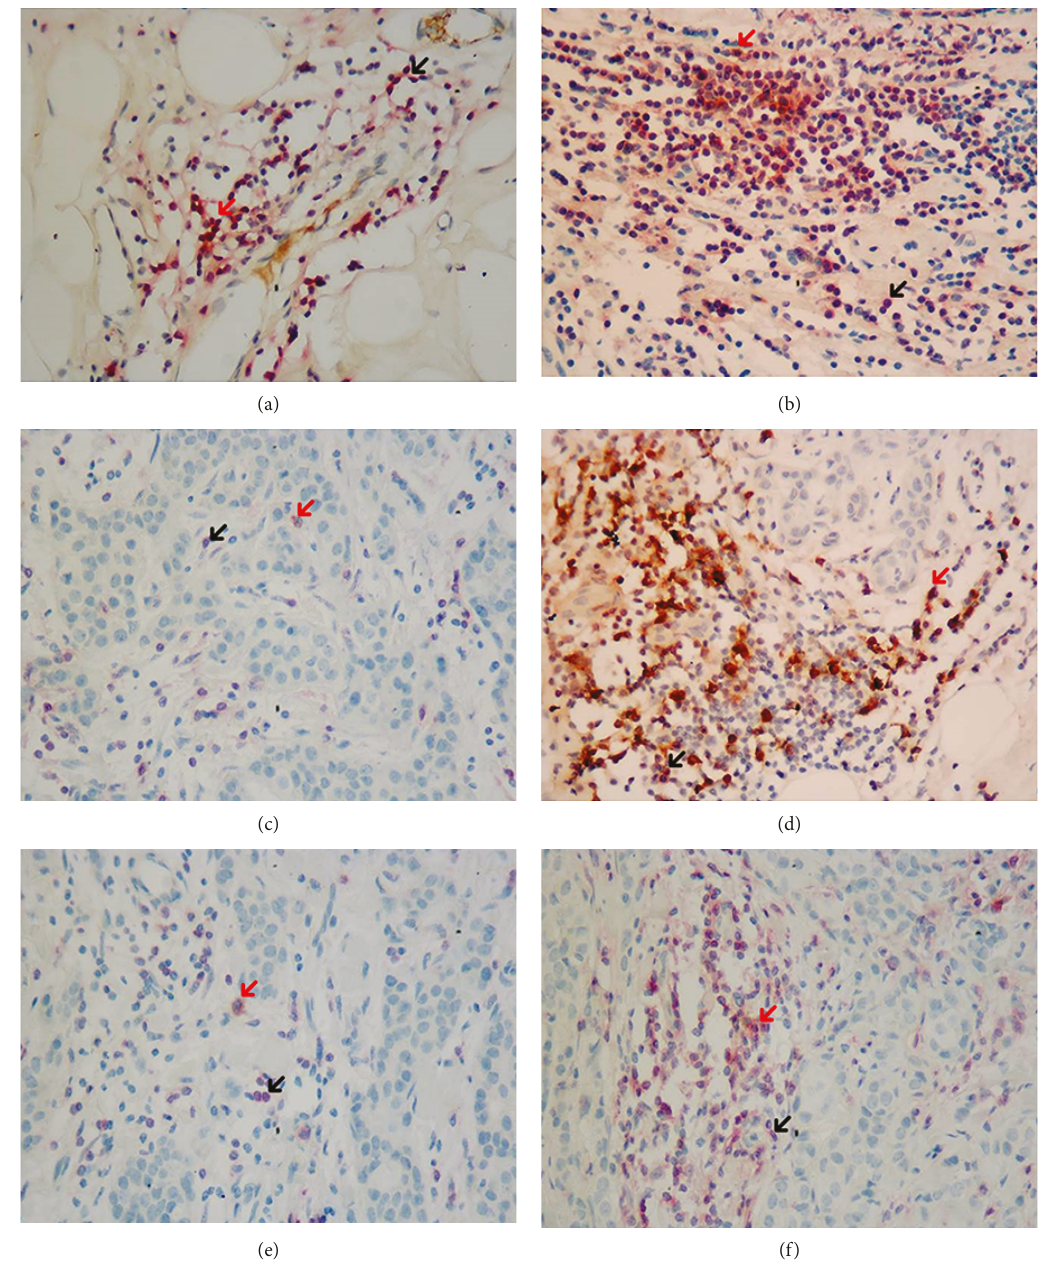
Figure 2: Expression of E-Cad, Ki-67, and CK-20 and counts of phenotypes of CD8/PD-1 TILs. (a) Patients with negative E-Cad expression (IHC, × 400); (b) patients with positive E-Cad expression (IHC, × 400); (c) patients with negative Ki-67 expression (IHC, × 400); (d) patients with positive Ki-67 expression (IHC, × 400); (e) patients with negative CK20 expression (IHC, × 400); (f) patients with positive CK20 expression (IHC, × 400). → (red) CD8 + /PD-1 + TILs; → (black) CD8 + /PD-1 - TILs. CD8 + /PD1 + TILs showed a red cytomembrane and brown cytoplasm, and CD8 + /PD1 - TILs showed a red cytomembrane. Patients with negative E-Cad had less CD8 + /PD-1 - TILs than positive patients; patients with negative Ki-67 had less CD8 + /PD-1 + and CD8 + /PD-1 - TILs than positive patients; and patients with negative CK20 expression had less CD8 + /PD-1 - TILs than positive